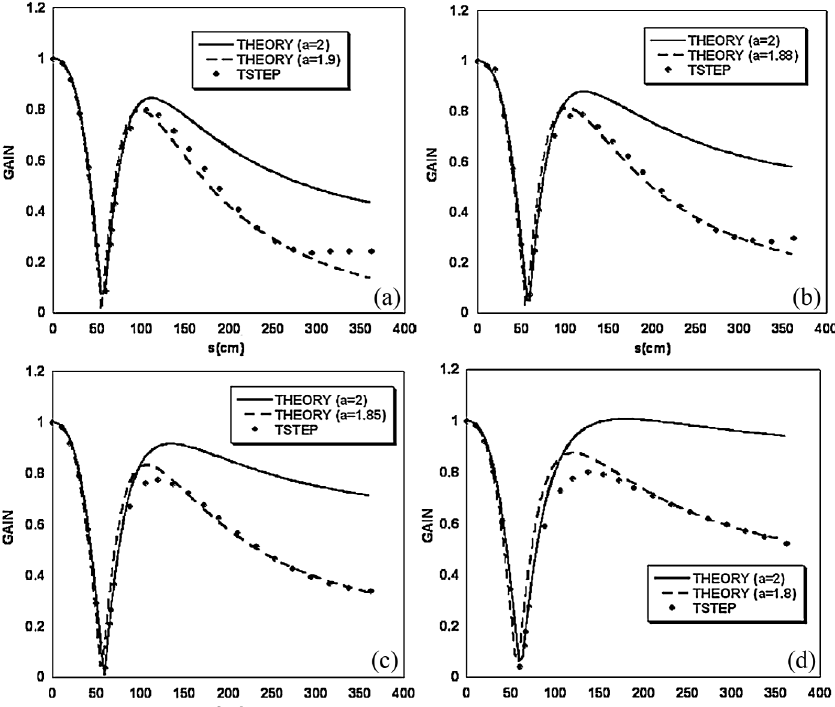
¼ (cid:1) 82 deg rf phase. The linear gain along the compressor FIG. 9. Comparison between TSTEP simulations and linear theory for (cid:2) 0 is shown for four different initial modulation wavelengths: (a) 50 (cid:12) m , (b) 75 (cid:12) m , (c) 100 (cid:12) m , and (d) 150 (cid:12) m . The dashed line and solid lines were obtaining by setting a ¼ 2 and a ¼ 1 : 95 – 0 : 001 (cid:5) ½ (cid:12) m (cid:3) , respectively, in the linear